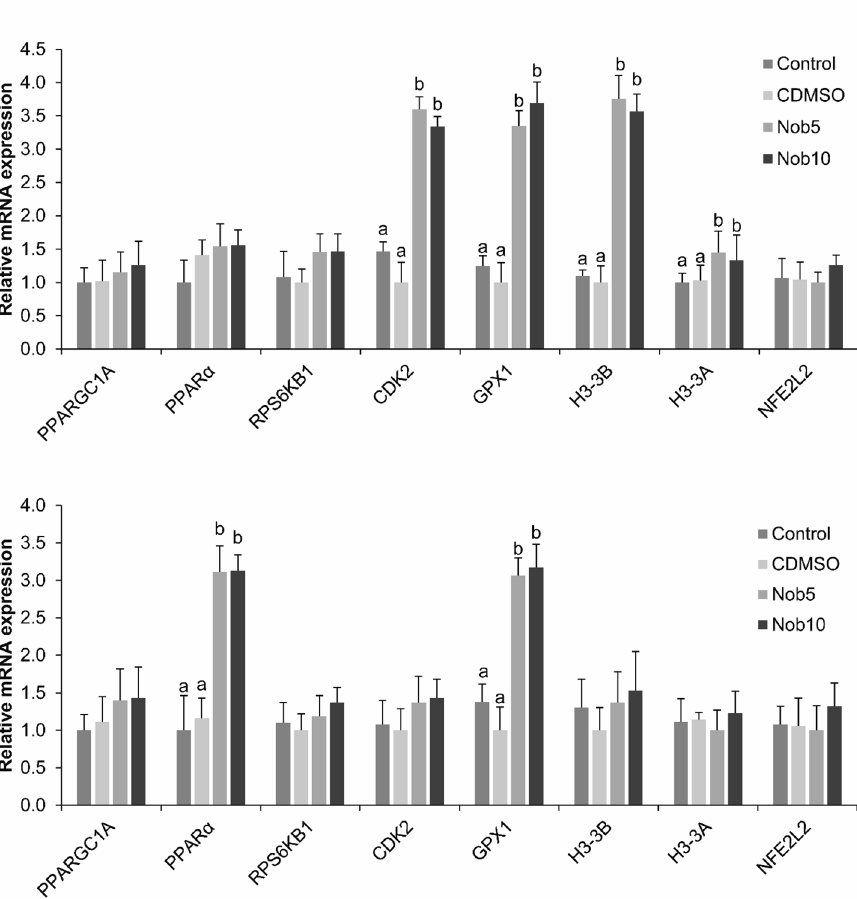
Figure 4. Relative mRNA transcript abundance of embryo development-related genes in in vitro produced embryos cultured during 21–54 h post insemination (MN EGA : presumptive zygote to 8-cell stage) with or without nobiletin. ( a ) Relative abundance in 8-cell stage embryos cultured in SOF + 5% FCS (Control), supplemented or not with 5 (Nob5) or 10 µM (Nob10) nobiletin or with 0.03% dimethyl sulfoxide (C DMSO ) during MN EGA phase. ( b ) Relative abundance in blastocysts from Control, Nob5, Nob10, and C DMSO experimental groups from MN EGA phase. The relative abundance of the transcripts was normalized to H2AFZ and ACTB as housekeeping genes. Data are the mean ± s.e.m. Different letters indicate significant difference ( P < 0.05) between